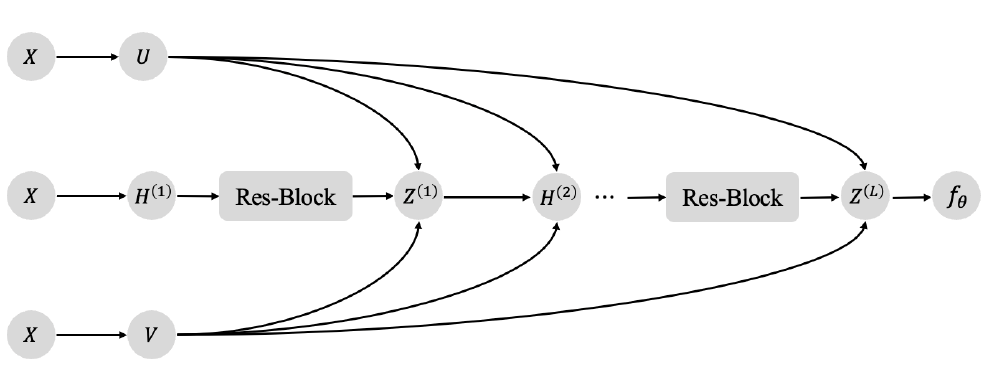
Figure 3. The ResNet block-enhanced modified architecture for physics-informed neural